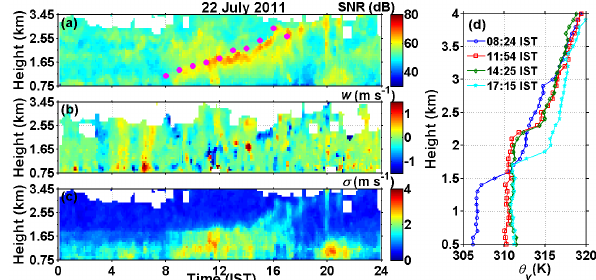
Figure 6. Diurnal variation of profiler attributes (a) range-corrected SNR (b) w and (c) σ on 22 July 2011, illustrating the evolution of the ABL and afternoon transition. (d) The vertical variation of radiosonde-derived θ v at ∼ 3h intervals. The solid symbols in (a) indicate the height of the ABL.